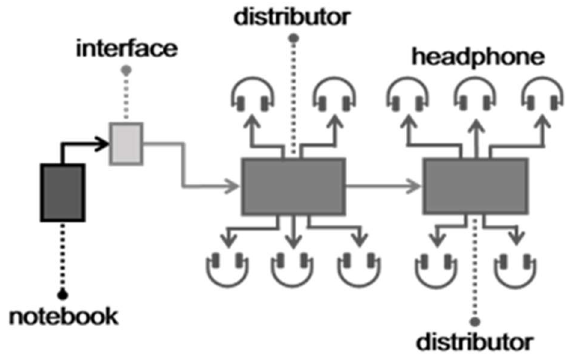
Figure 10. Equipment configuration map.